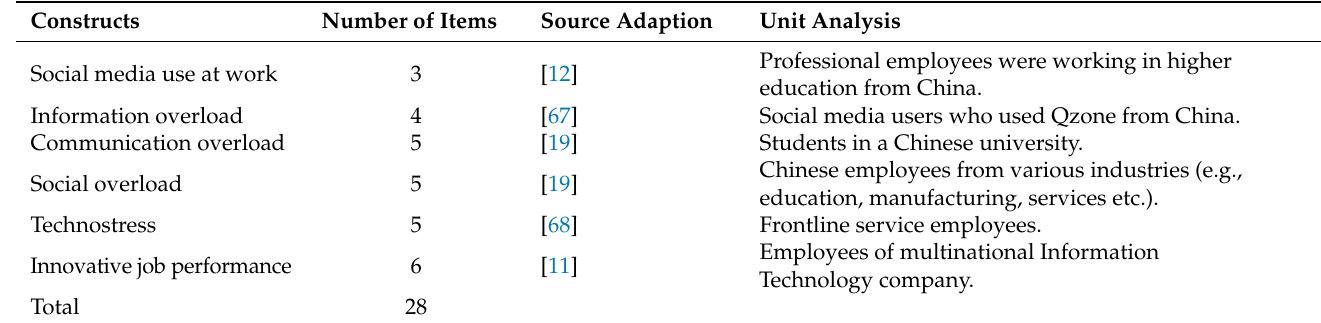
Table 2. The list of variables measured in this